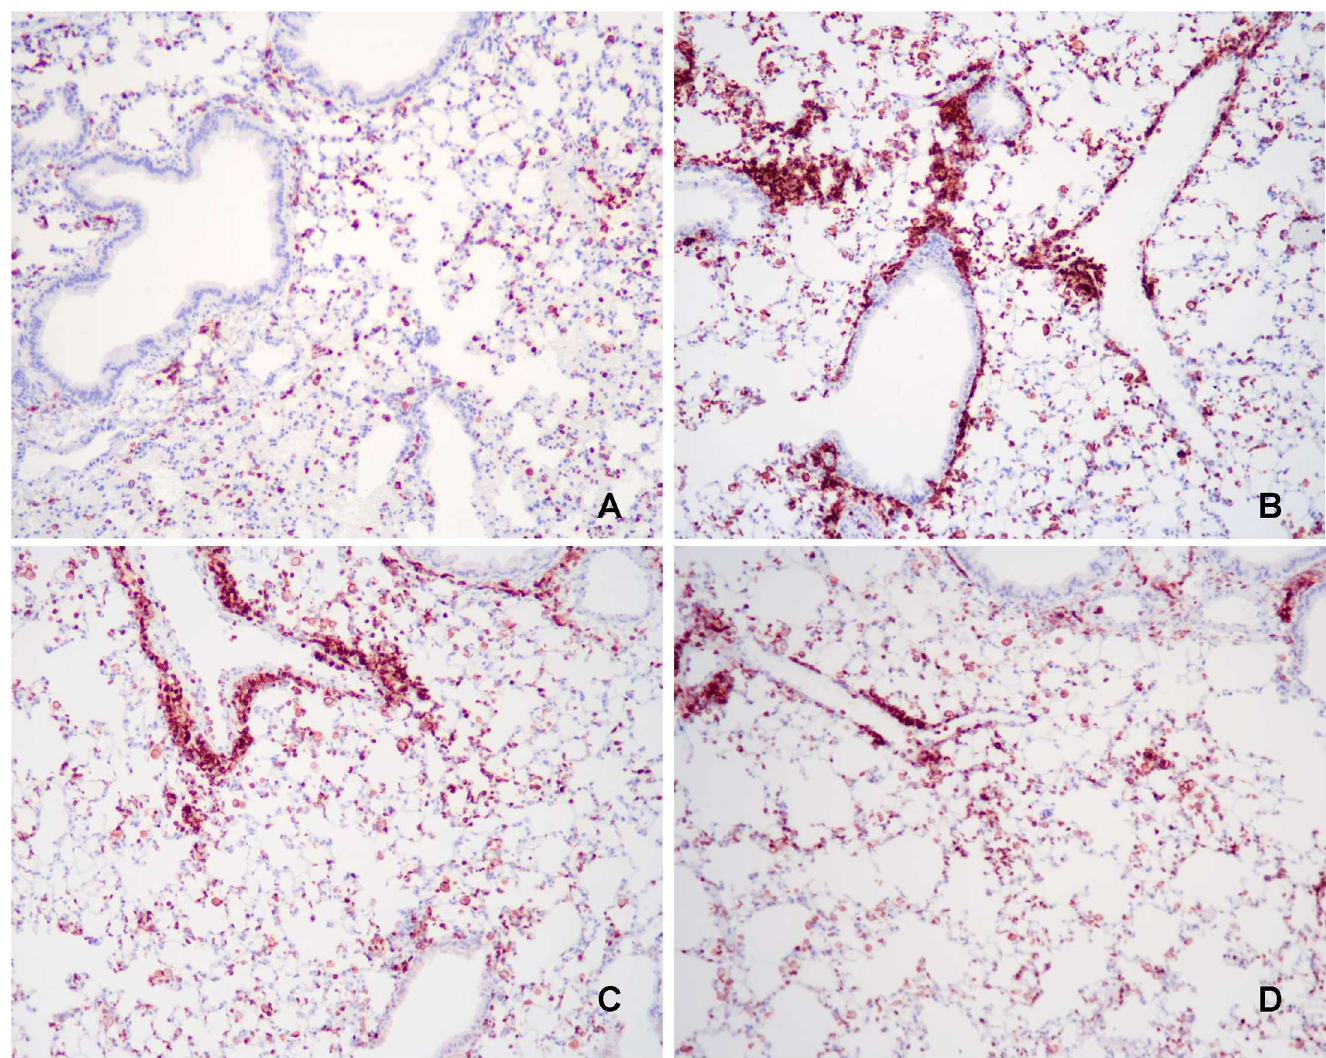
Fig 3. Representative light microscopy images of lung tissue. Lung tissues were stained with rat anti-mouse CD45 after mice were fed their respective foods for 12 weeks. They were sensitized and challengedwith saline or OVA starting at 8 weeks. (A) Only circulating leukocytesare seen in control mice fed standard rodent food and sensitized and challengedwith saline(Negative Control). (B) Mice fed standard rodent food and sensitized and challengedwith OVA (Positive Control) or (C) Corn Oil-enriched food exhibit a marked increase in CD45+ inflammatory cells, particularlyperibronchial infiltrates. (D) Overall, there were less CD45+ inflammatory cells in mice fed Fish-Oil enriched food compared with mice fed control food (Positive Control; P = 0.04). Original magnification